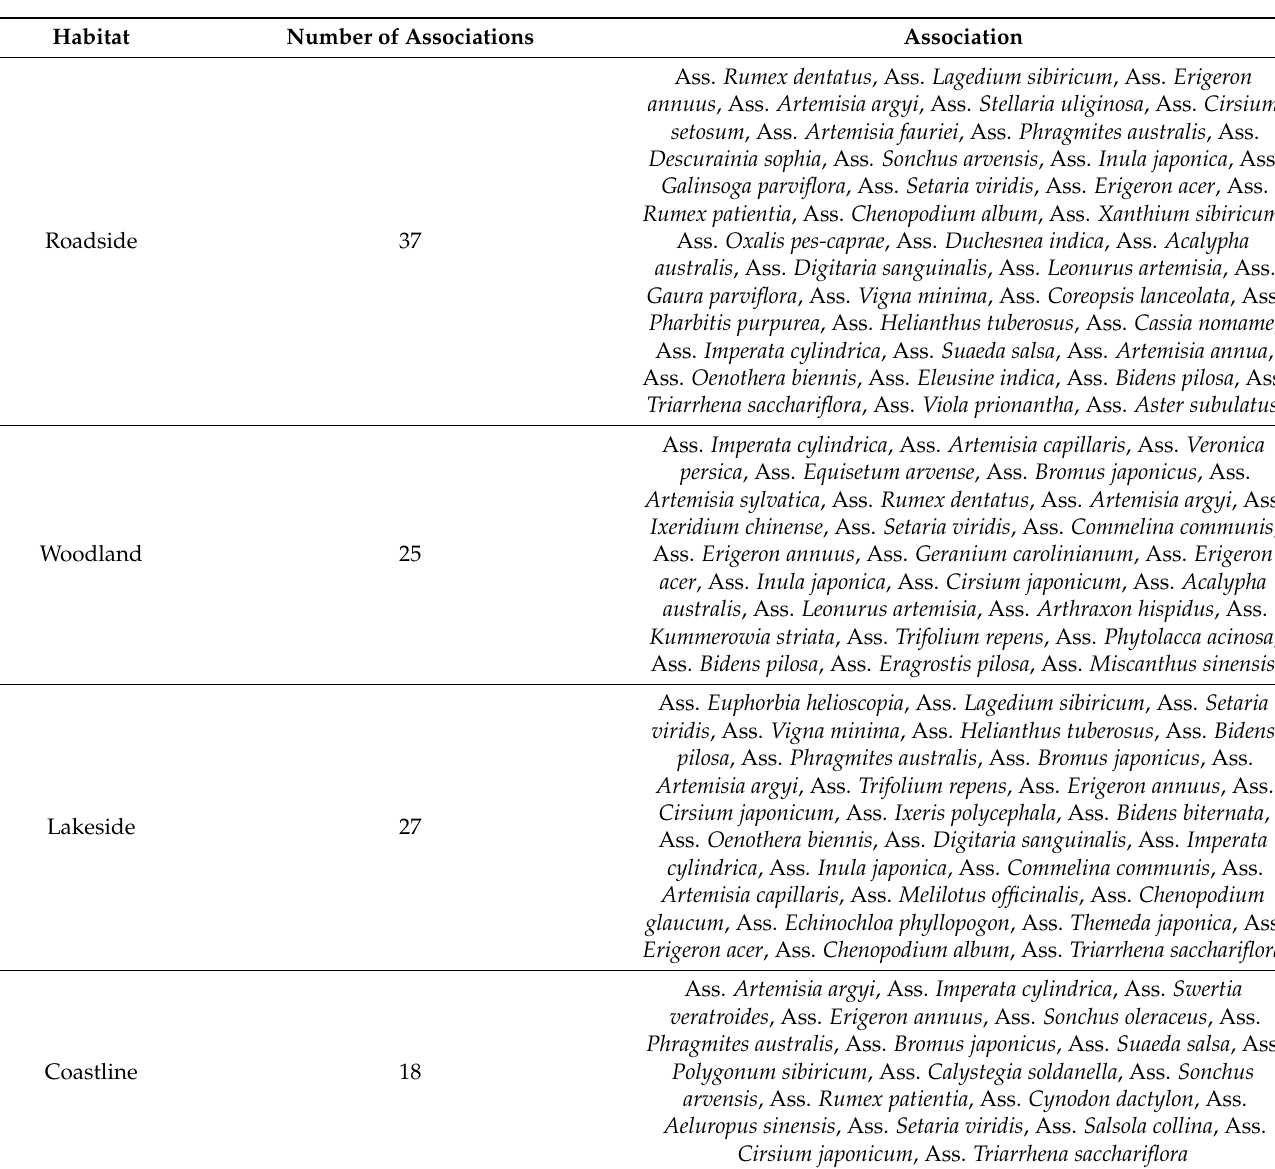
Table 1. The associations of spontaneous plants in different habitats of the Tangdao Bay National Wetland